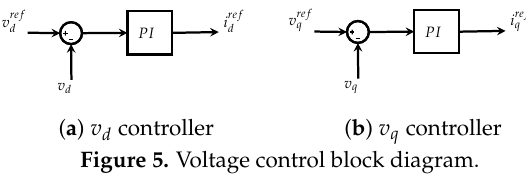
Figure 5. Voltage control block diagram.